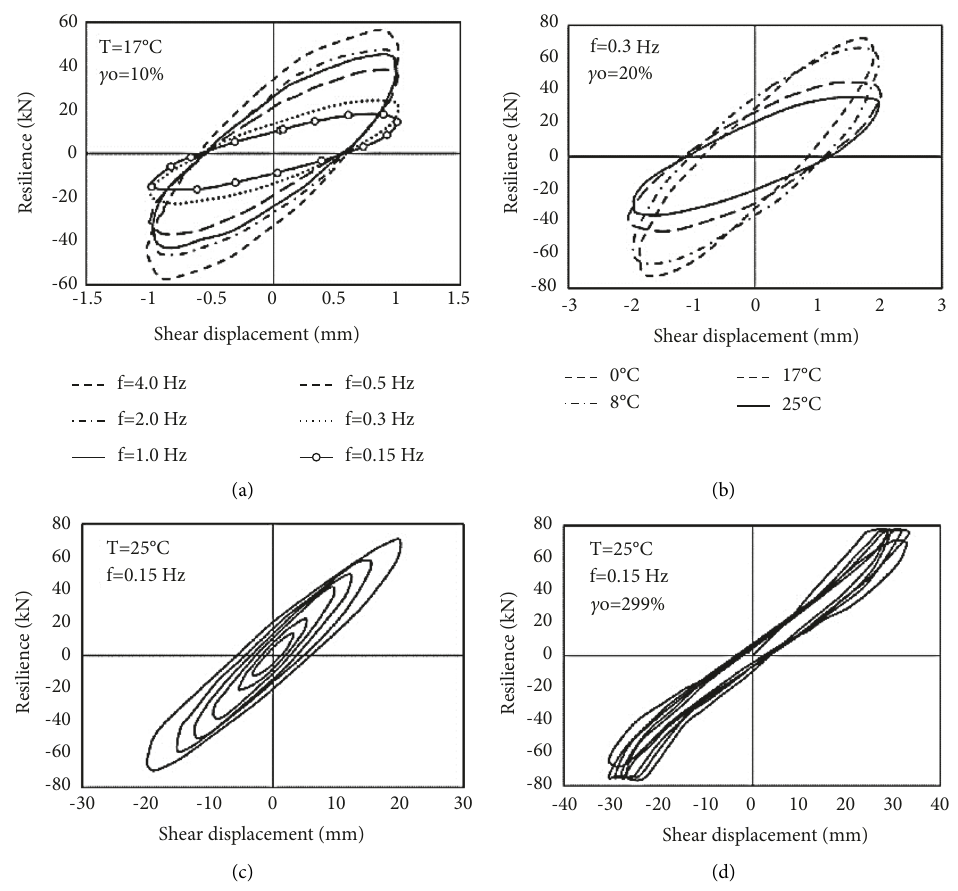
Figure 2: Viscoelastic damping residual curve [33]: (a) different excitation frequency; (b) different ambient temperature; (c) different shear strain amplitude; (d) damper